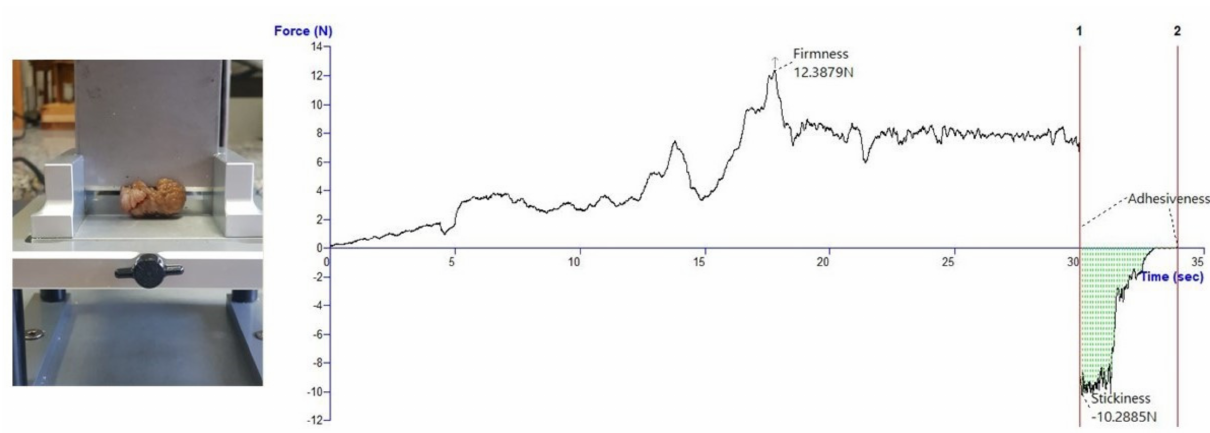
Figure 5. Texture analysis: curve force versus time for cutting